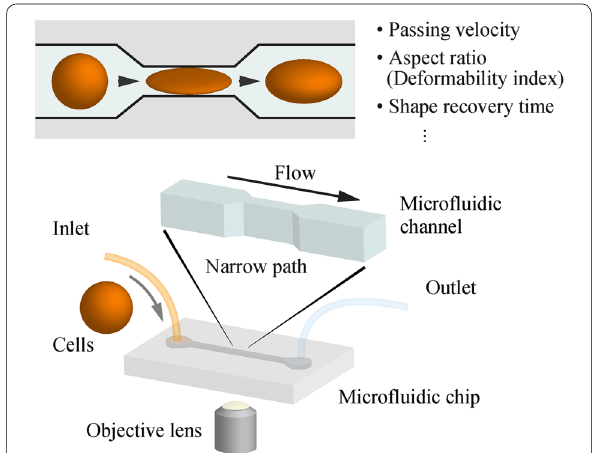
Fig. 2 Typical cellular deformability test in a microfluidic channel